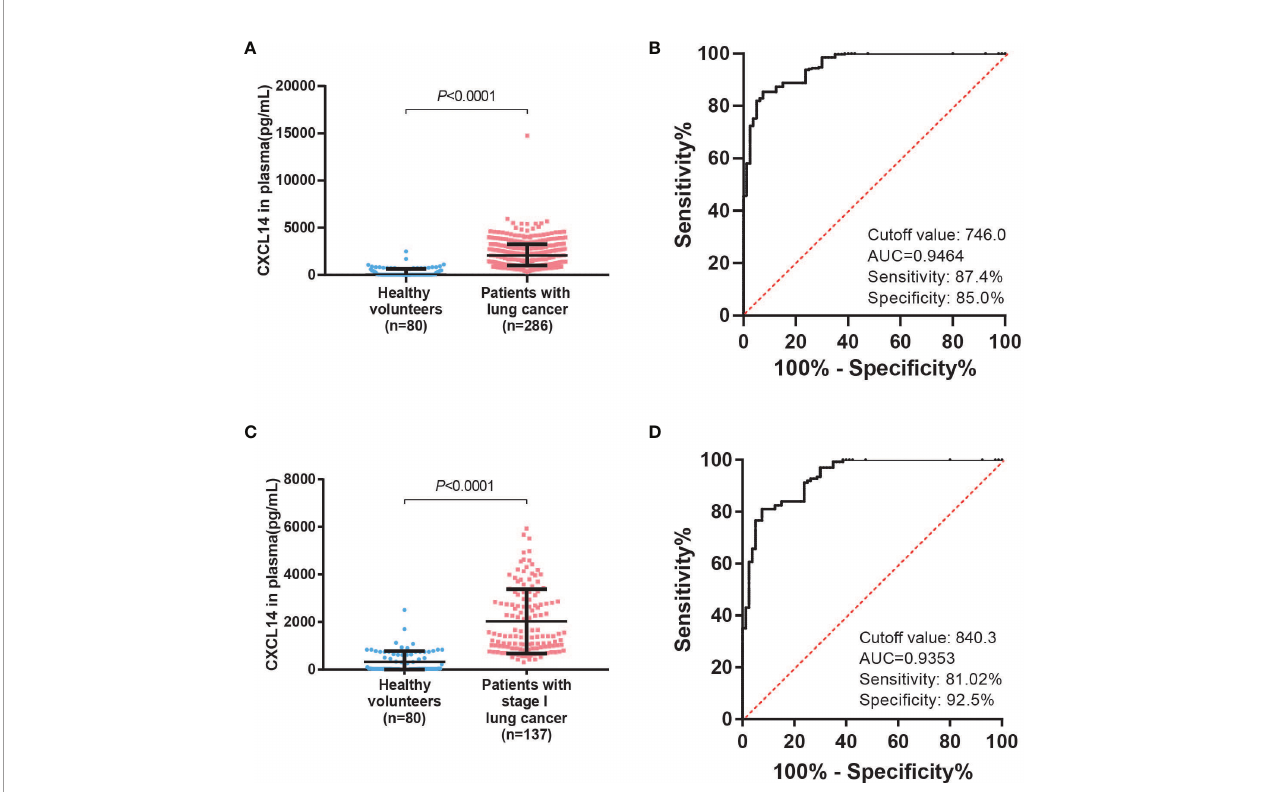
FIGURE 2 | Plasma CXCL14 as a diagnostic biomarker in distinguishing lung cancer patients from control subjects. (A) Comparison of the CXCL14 concentration (determined by ELISA) in plasma between control subjects (n=80) and lung cancer patients (n=286) in a retrospective cohort. P <0.0001 determined by Mann – Whitney U tests. (B) ROC analysis of the diagnostic ef fi ciency of CXCL14 in control subjects versus lung cancer patients in a retrospective cohort (AUC=0.9464, 95% CI: 0.9209 – 0.9719). (C) Comparison of the CXCL14 concentration (determined by ELISA) in plasma between control subjects (n=80) and stage I lung cancer patients (n=137) in a retrospective cohort. P <0.0001 determined by Mann – Whitney U tests. (D) ROC analysis of the diagnostic ef fi ciency of CXCL14 in control subjects versus stage I lung cancer patients in a retrospective cohort (AUC=0.9353, 95% CI: 0.9034 – 0.9672). Scatter diagrams present the median values with interquartile